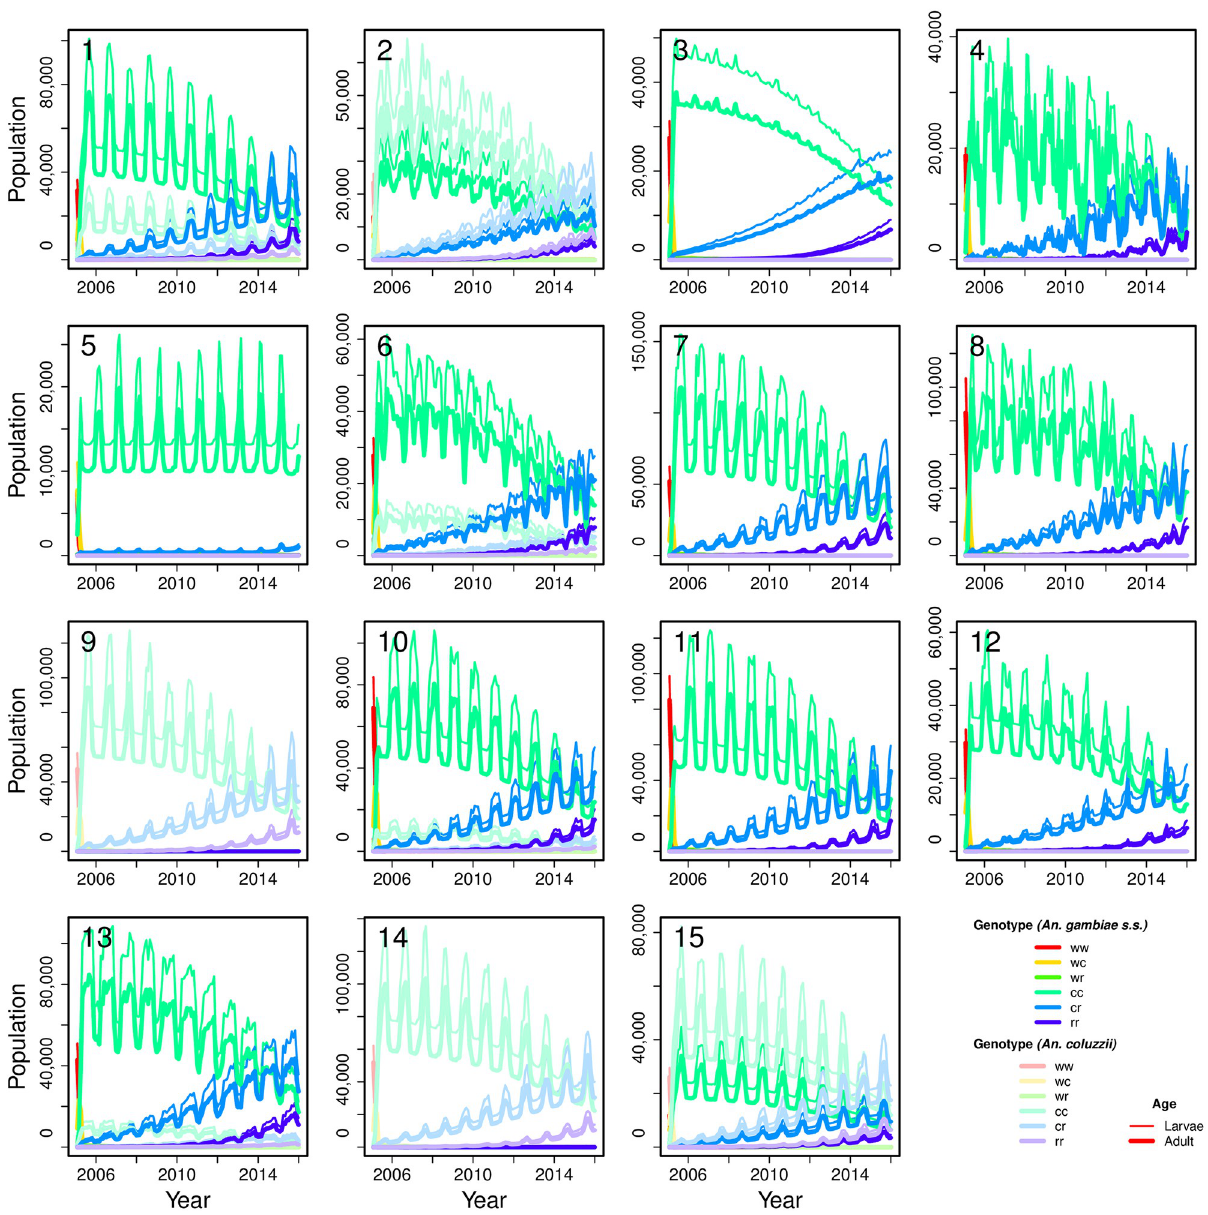
Fig 5. The time series abundance of male mosquitoes at each introduction point (the sub-figure number corresponds to the release site; see Fig 4), separated by species, genotype and age (female mosquitoes occur in identical numbers to males in this model). The colours correspond to genotype and the line thickness to age